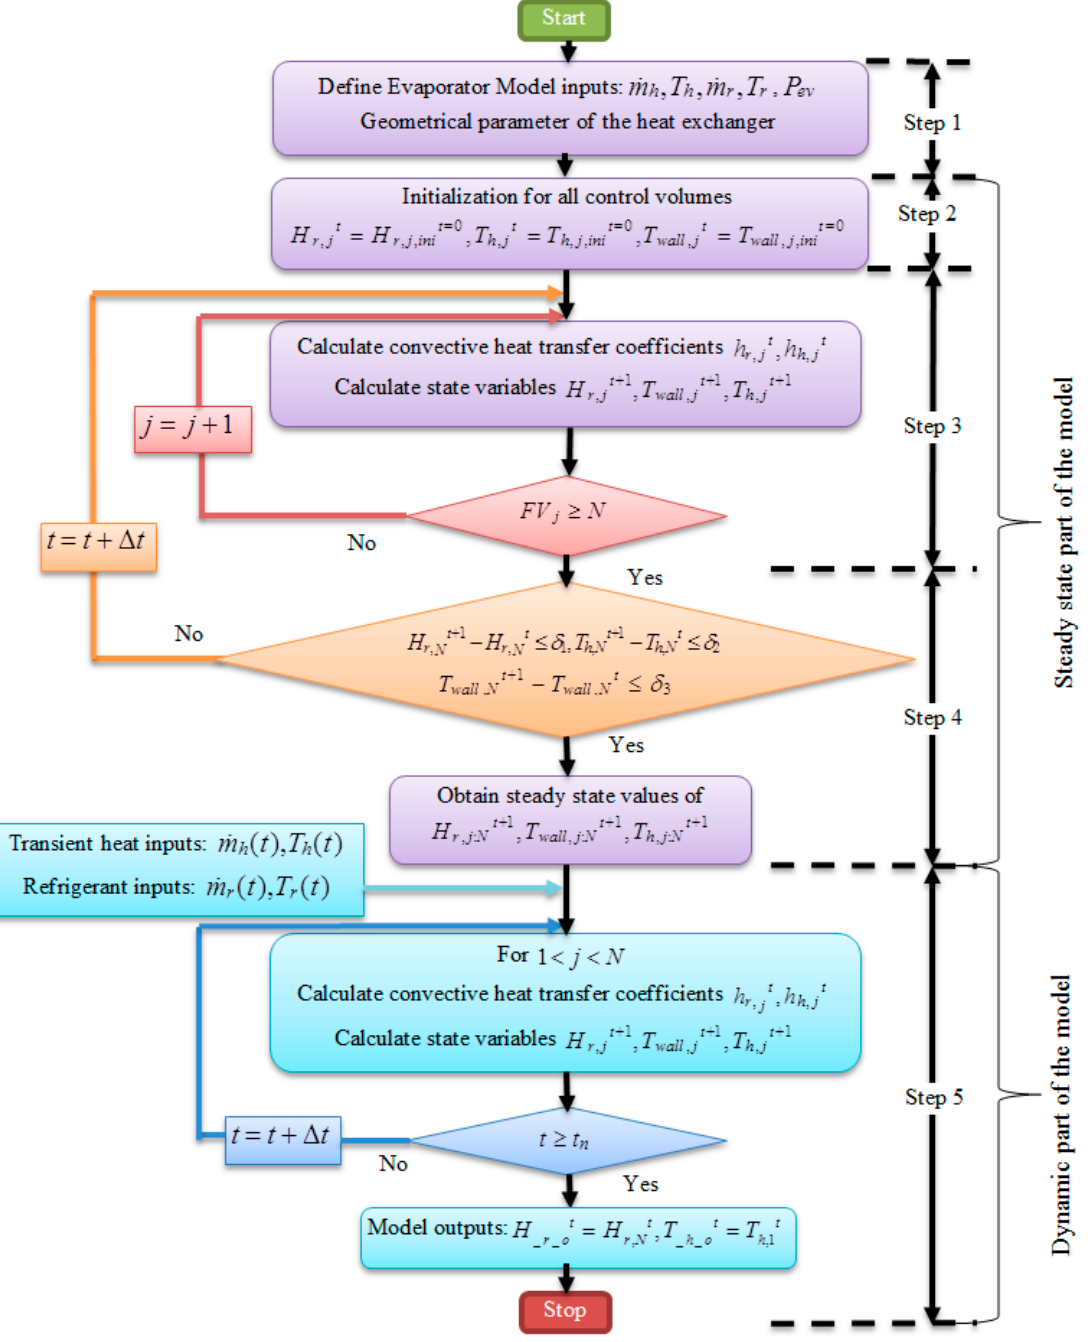
Figure 4. Program flow-chart of the dynamic evaporator model.